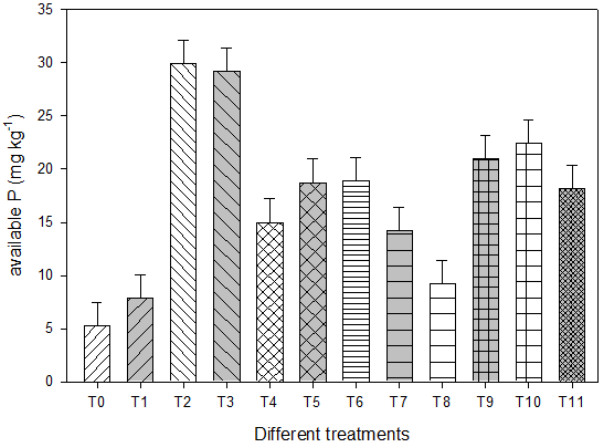
Figure 1. The P release capacity of different P sources applied alone or in combination with PSB and PM (average over incubation pe- riods) to a soil incubated under controlled laboratory conditions at 25 ◦ C. The legend on x axis refers to the different treatments: T 0 – control; T 1 – RP; T 2 – SSP; T 3 – DAP; T 4 – PM full; T 5 – 1 / 2 RP + 1 / 2 SSP; T 6 – 1 / 2 RP + 1 / 2 DAP; T 7 – 1 / 2 RP + 1 / 2 PM; DAP + PSB; T 11 – 1 / 2 RP + 1 / 2 PM + PSB. Full dose of P from dif- ferent sources was applied at the rate of 90mgPkg − 1 soil.